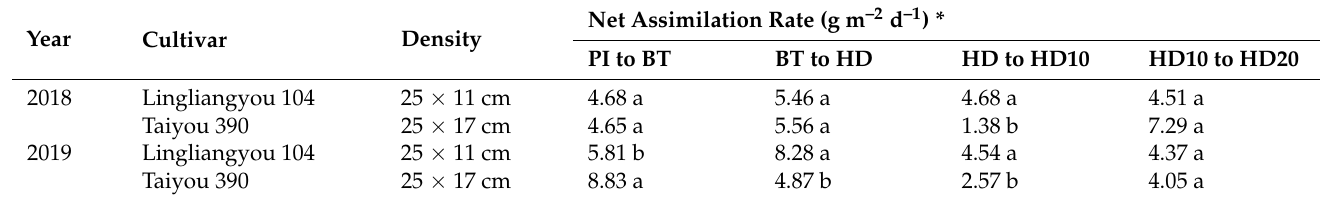
Table 7. Net assimilation rate of two growth-duration rice cultivars under two planting densities in 2018 and